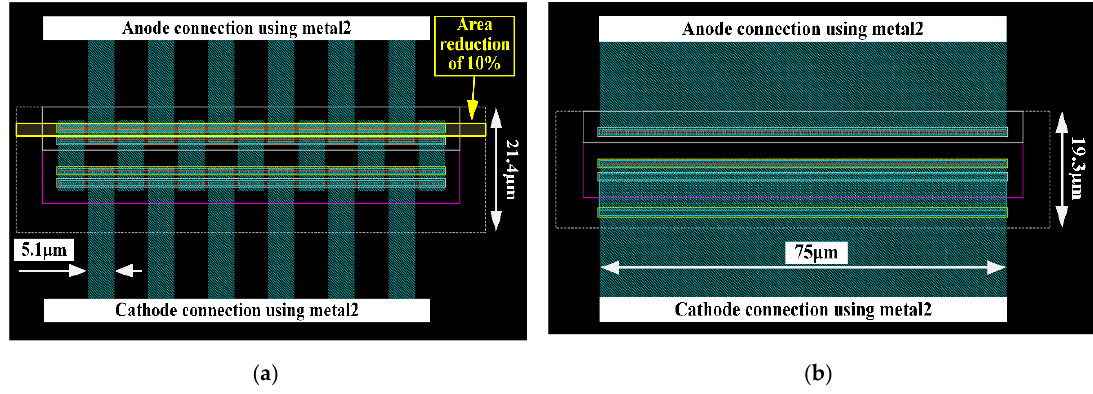
Figure 5. Layout top views and device dimensions of ( a ) conventional DCSCR; and ( b ) proposed ERTSCR. Both DCSCR and ERTSCR have a same device width of 75 μ m.